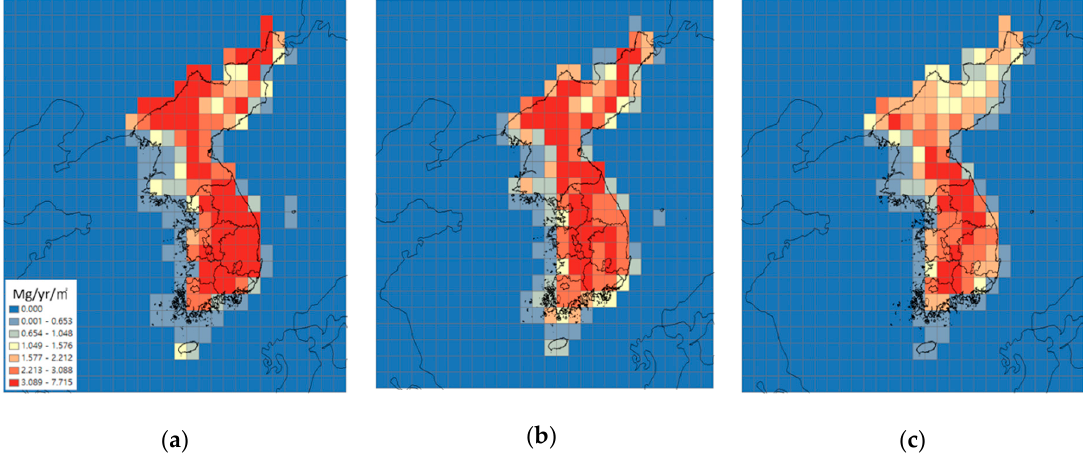
Figure 9. Distribution of isoprene emissions in 2014: ( a ) bottom-up emissions (Case 1); ( b ) bottom-up emissions (Case 4); ( c ) inverse emission estimates from GlobEmission [24].